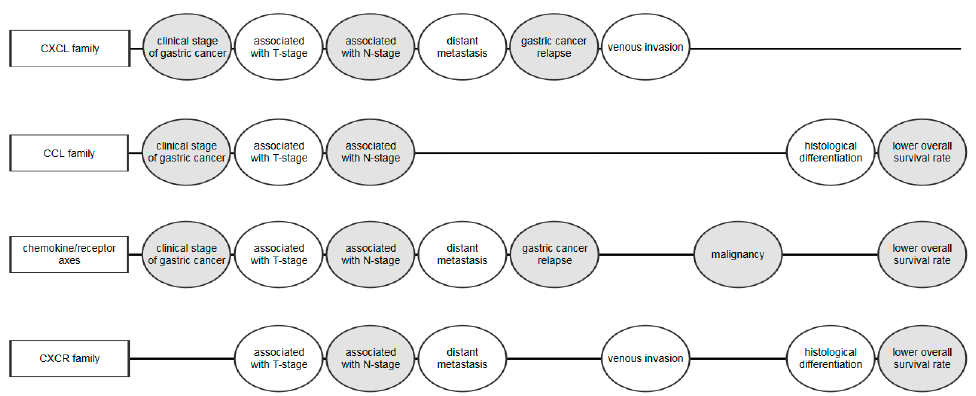
Figure 1. Correlations between the role of chemokines and features assessed in gastric cancer (GC) [10,16,19,24–43]. Rectangles represent chemokine ligand (CXCL and CCL) families, chemokine / receptor pairs, and chemokine receptors (CXCR) families analyzed in the study. Ellipses represent selected features in gastric cancer correlated with concentration or expression of chemokine families, chemokine / receptor pairs, and chemokine receptors. T-stage—depth of tumor invasion. N-stage—presence of lymph node metastasis. Table 1. The role of CXCL (CXC chemokine ligand) in gastric cancer (GC). Chemokines Results